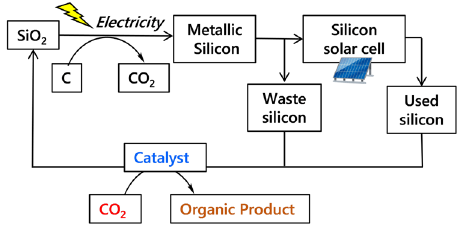
Fig. 1 Proposed Si recycling process with CO 2 conversion to organic products. Waste/used silicon could be recycleed as a reducing agent of CO 2 to form value-added organic products.